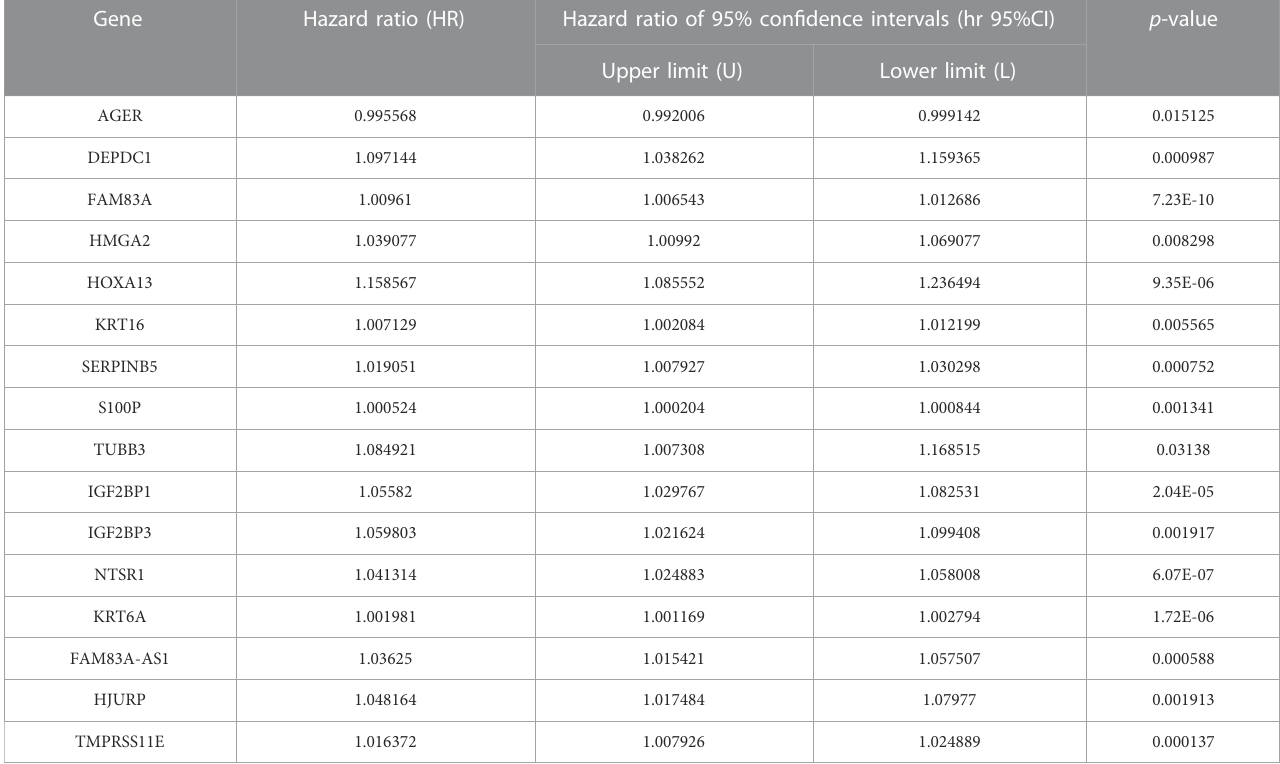
TABLE 1 Signi fi cant prognostic value of EMT-LUAD related genes for the survival of LUAD patients by univariate Cox proportional hazards regression analysis.